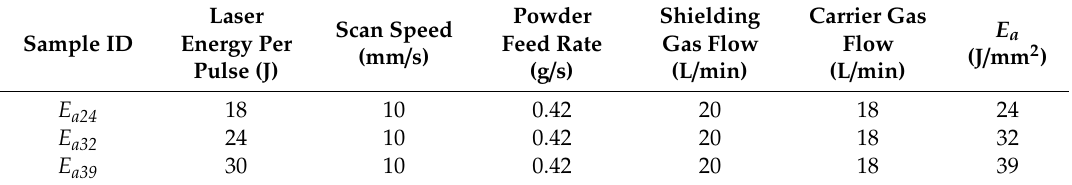
Table 1. Yb: YAG Laser operational parameters and calculated average energy per unit